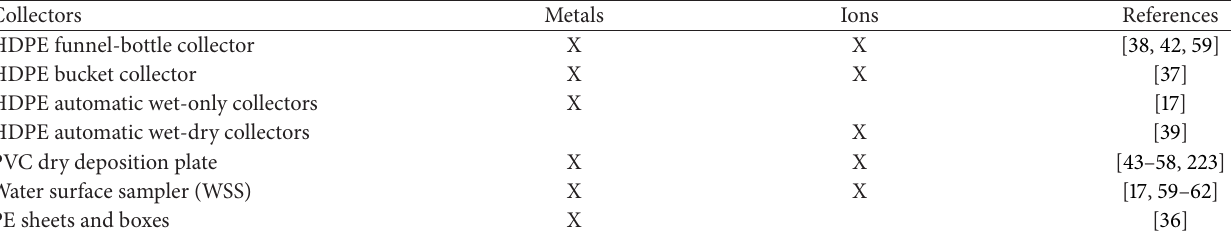
Table 3: List of different collectors used in sampling atmospheric deposition of inorganic pollutants (metals and